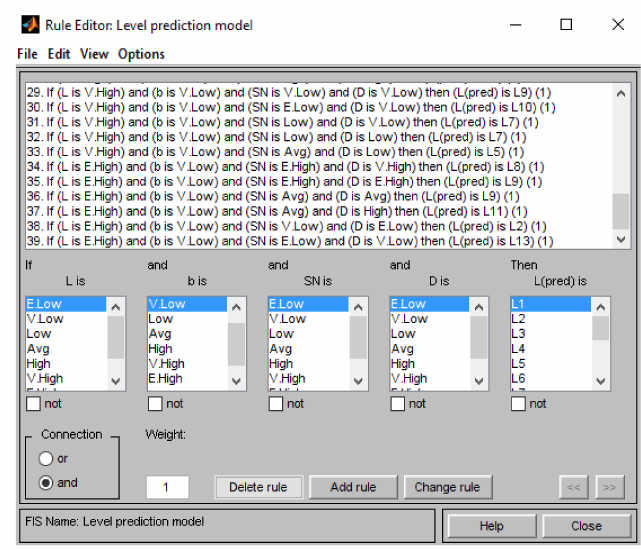
Figure 8. The rule editor in the MATLAB platform.